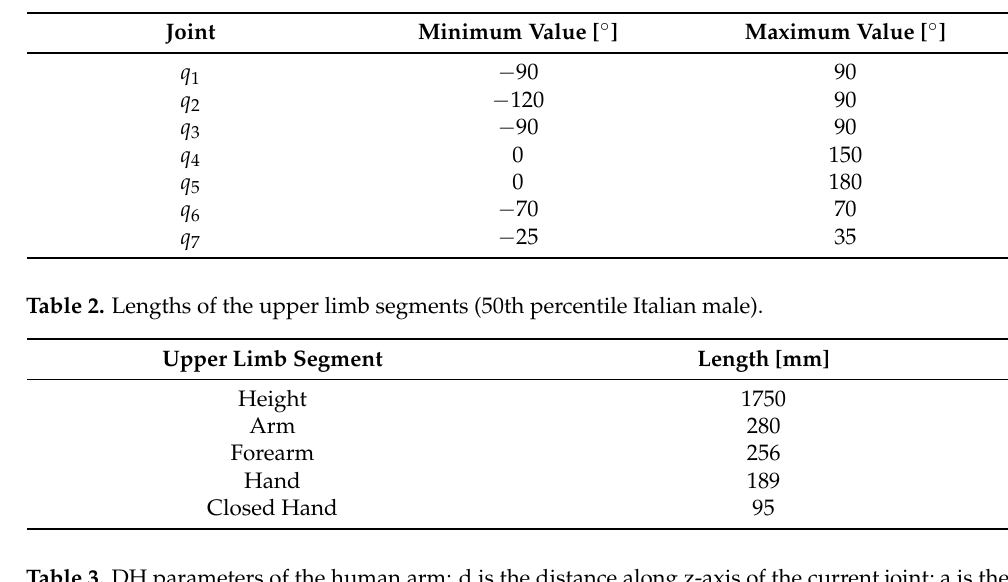
Table 3. DH parameters of the human arm: d is the distance along z-axis of the current joint; a is the distance along x-axis between two consecutive joint axis; α is the rotation around the x-axis of the current joint; off-set is the angle between the two consecutive x-axis about the z-axis of the previous joint [19]. d